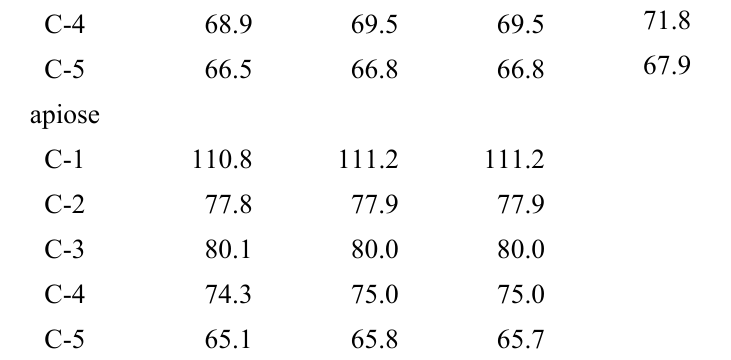
Figure 2 . HPLC profile of saponin fraction from the MeOH root extract of P. grandiflorum.